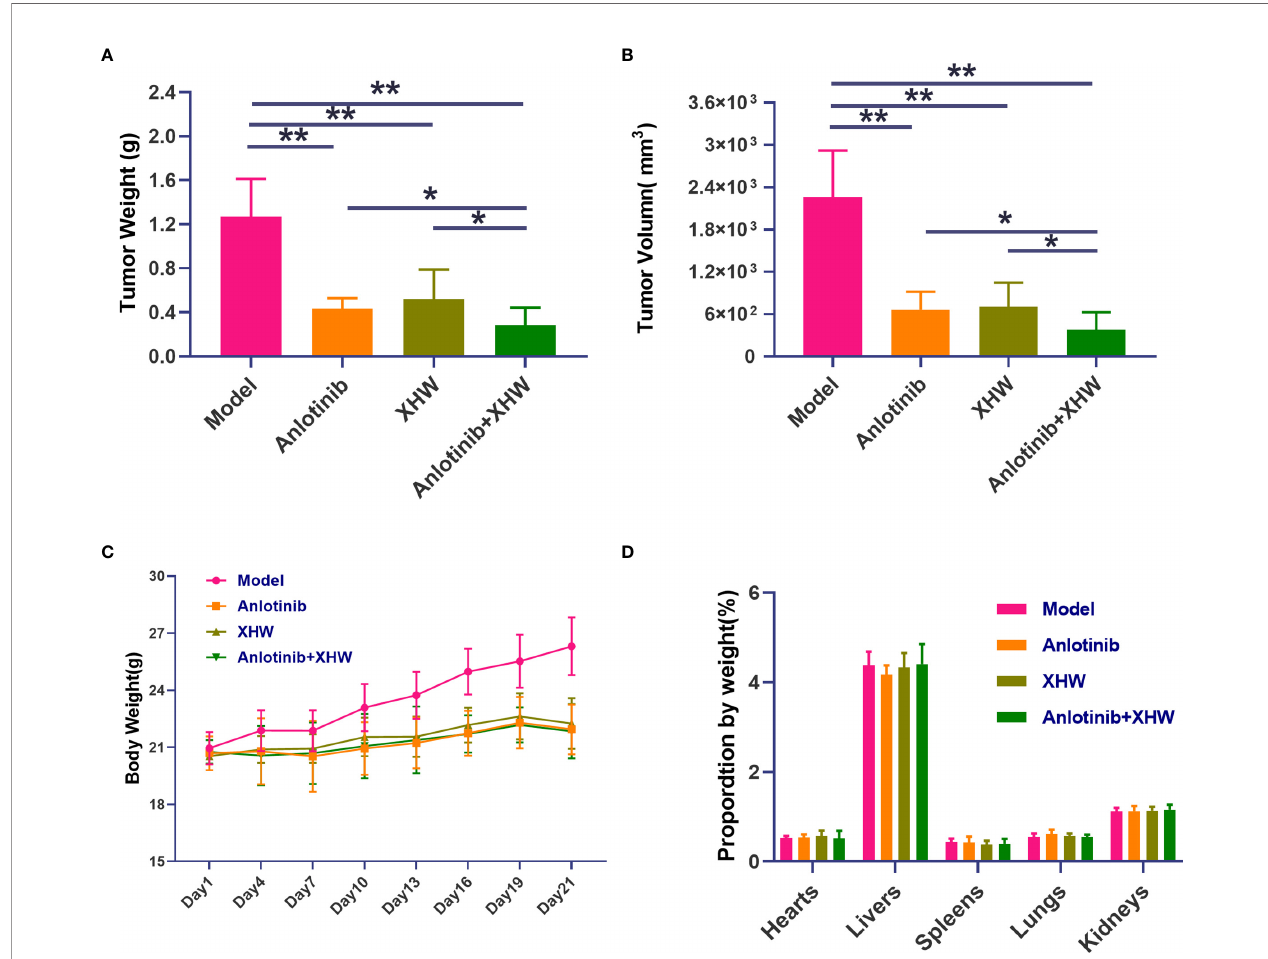
FIGURE 1 | Effect of cotreatment with anlotinib and XHWon the LLC mouse model. (A) Tumor weight, (B) tumor volume, (C) organ weight, and (D) body weight changes during the 21 days of the experiment. Data are mean ± SD. P values are based on ANOVA, **P<0.01 versus model, *P<0.05 versus model. N = 9 – 10 in each